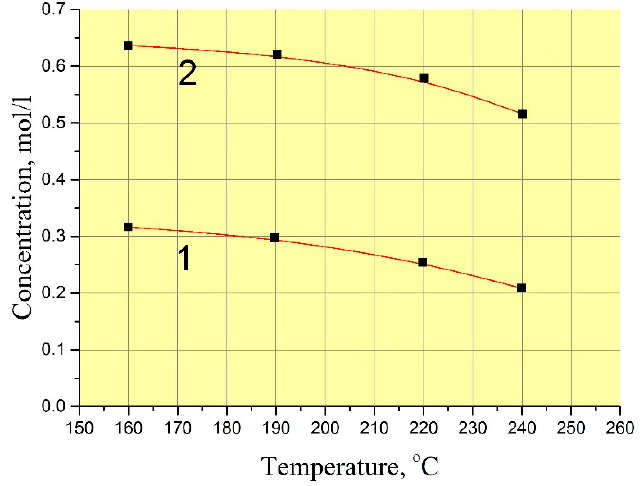
Figure 2. GaPO 4 concentration in 9 M H 3 PO 4 / 6 M HCl (vol. proportion 95 / 5%) at temperature 160–240 ◦ C and pressure 5–20 bar. 1—with crystallization; 2—without crystallization.